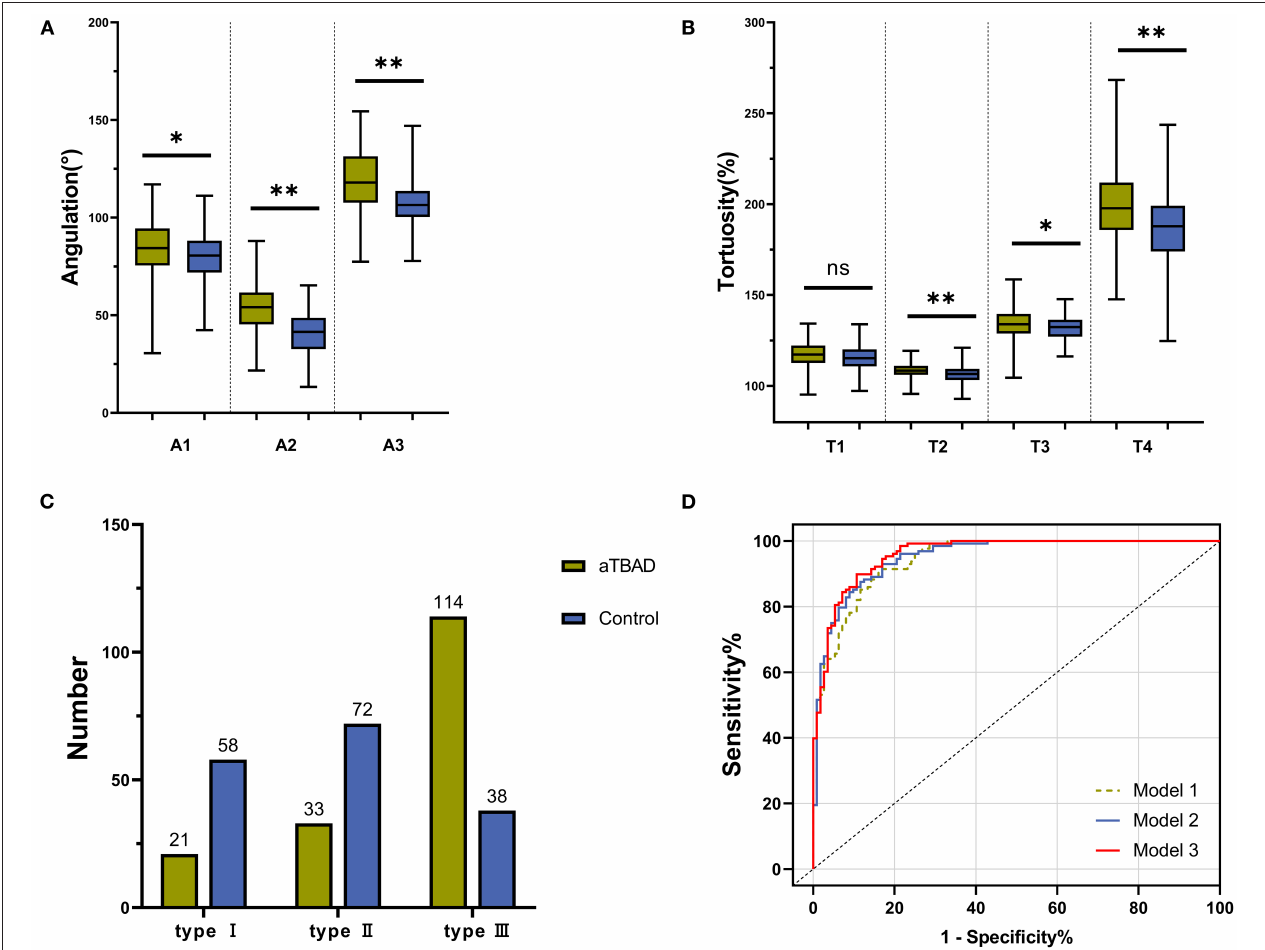
FIGURE 3 | Differences in geometric variables in each aortic segment between the aTBAD and control groups. (A,B) Difference in aortic angulation and tortuosity in each aortic segment between the study groups. (C) Number of patients with aortic arch types I to III in the aTBAD and control groups. (D) Receiver operating characteristic (ROC) curves of the multivariable logistic regression models. * P < 0.05, ** P ≤ 0.001, ns, no statistical significance.